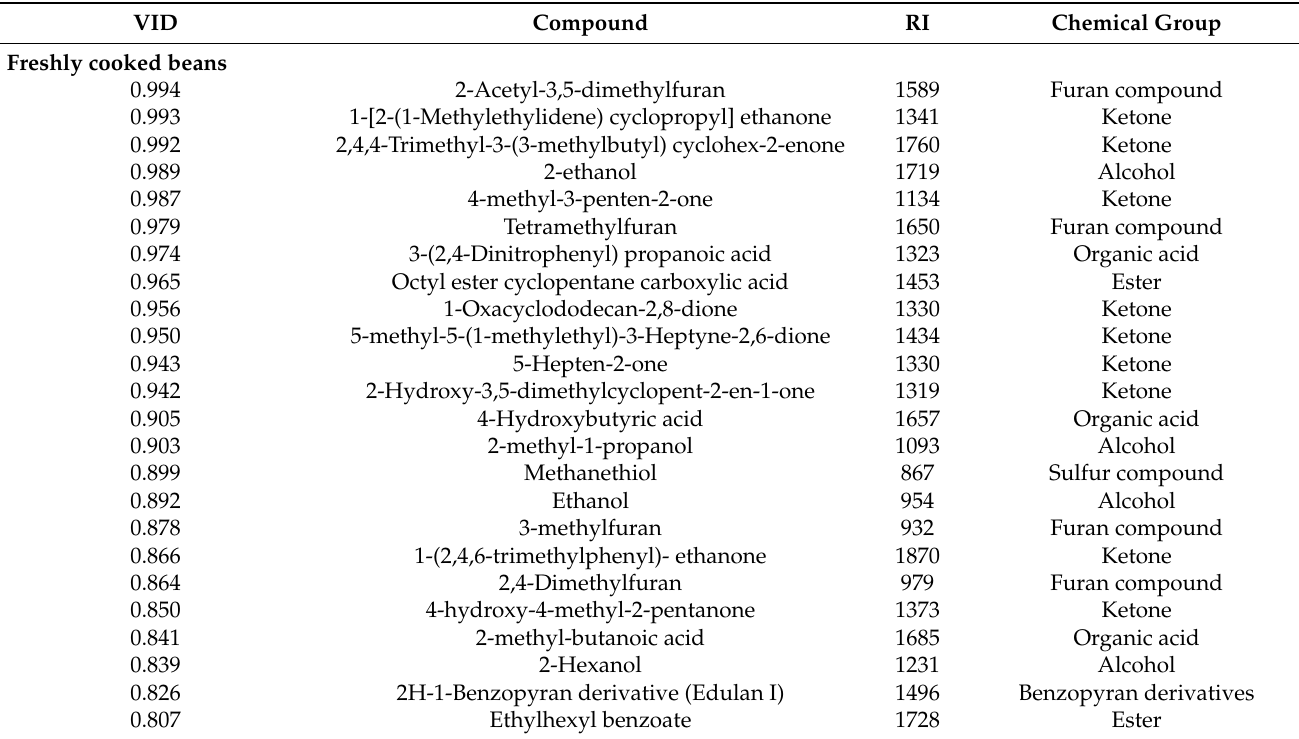
Figure 5. PLS-DA bi-plot of the headspace fraction of cooked ( (cid:4) ) and rehydrated air-dried ( (cid:78) ), vacuum-dried ( • ) and freeze-dried ( (cid:72) ) beans. The open circles are the volatile compounds among which the discriminant compounds are marked in bold. The correlation loading for the Y variable is represented by the vector. The percentages of X and Y variance explained by each latent variable are indicated on the respective axes. Table 3. Discriminant volatile headspace components for each class selected by the VID procedure (>|0.80|). The compounds are listed in increasing order of VID, with a positive value indicating a higher concentration and vice versa. RI stands for retention index. Compounds in bold and italic are volatiles that were absent in freshly cooked beans. VID Compound RI Chemical